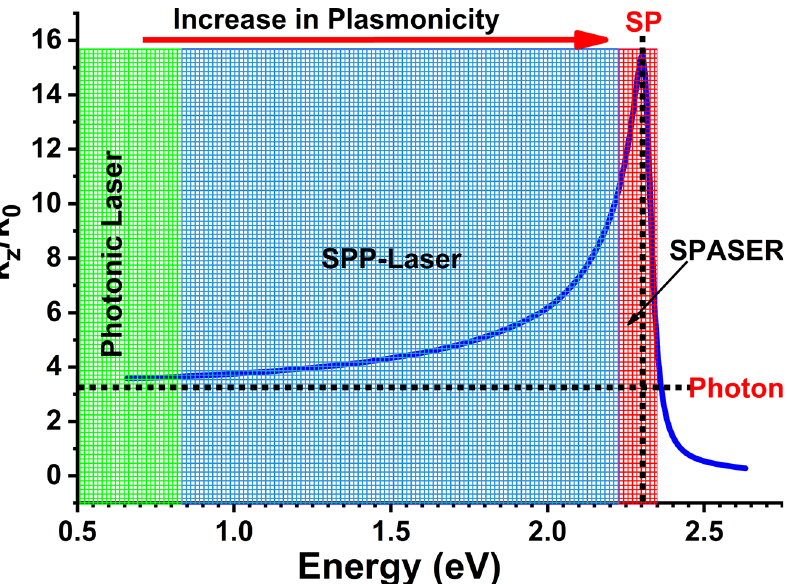
Figure 1: The normalized propagation wavevector versus energy plot for a semiconductor-silverinterface;therangeof energy is divided roughly into three regions depending on the “ plasmonicity ” , or the degree of proximity to the surface plasmon resonance (SP). We call the three regions: photonic laser (conventional laser), SPP-Laser, and SPASER. However, as Mark insisted and I initially opposed, there is no essential difference between the SPP-laser and the SPASER (figure adapted from Ref.